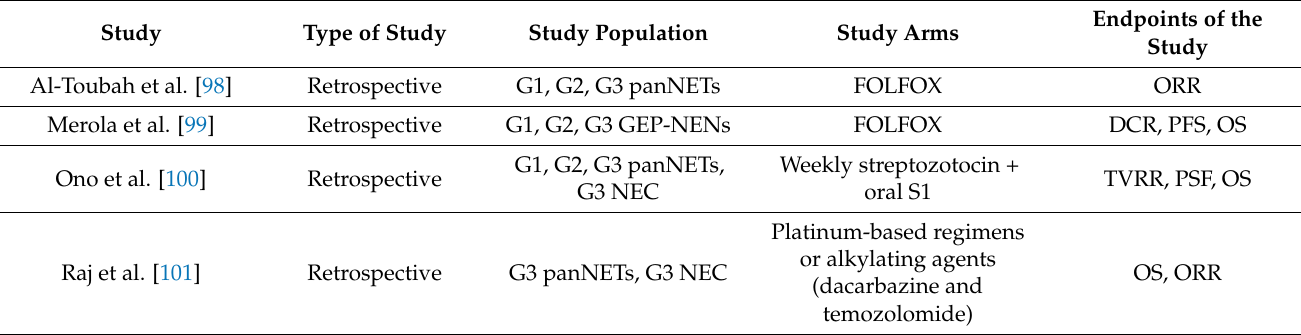
Table 5. Studies and trials of chemotherapy in the treatment of G3